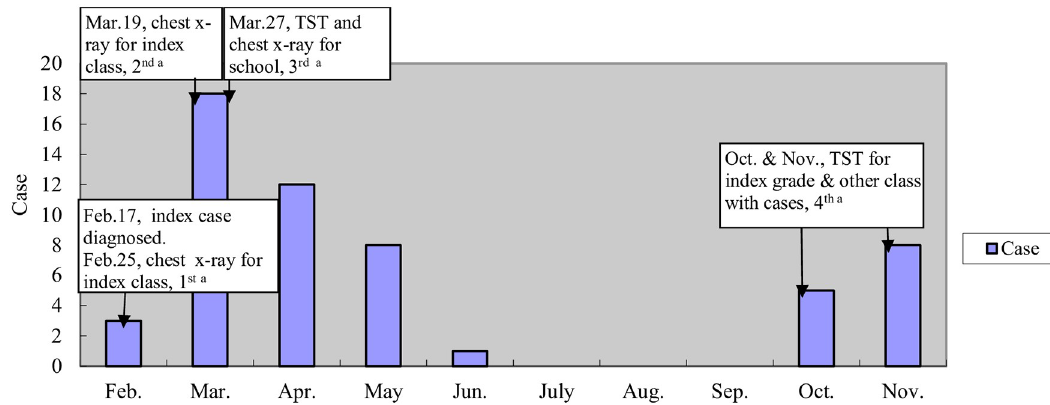
Fig 1. Timelines of TB screening and of cases diagnosed. a The four TB screenings. Abbreviations: TB, tuberculosis; TST, tuberculin skin test.